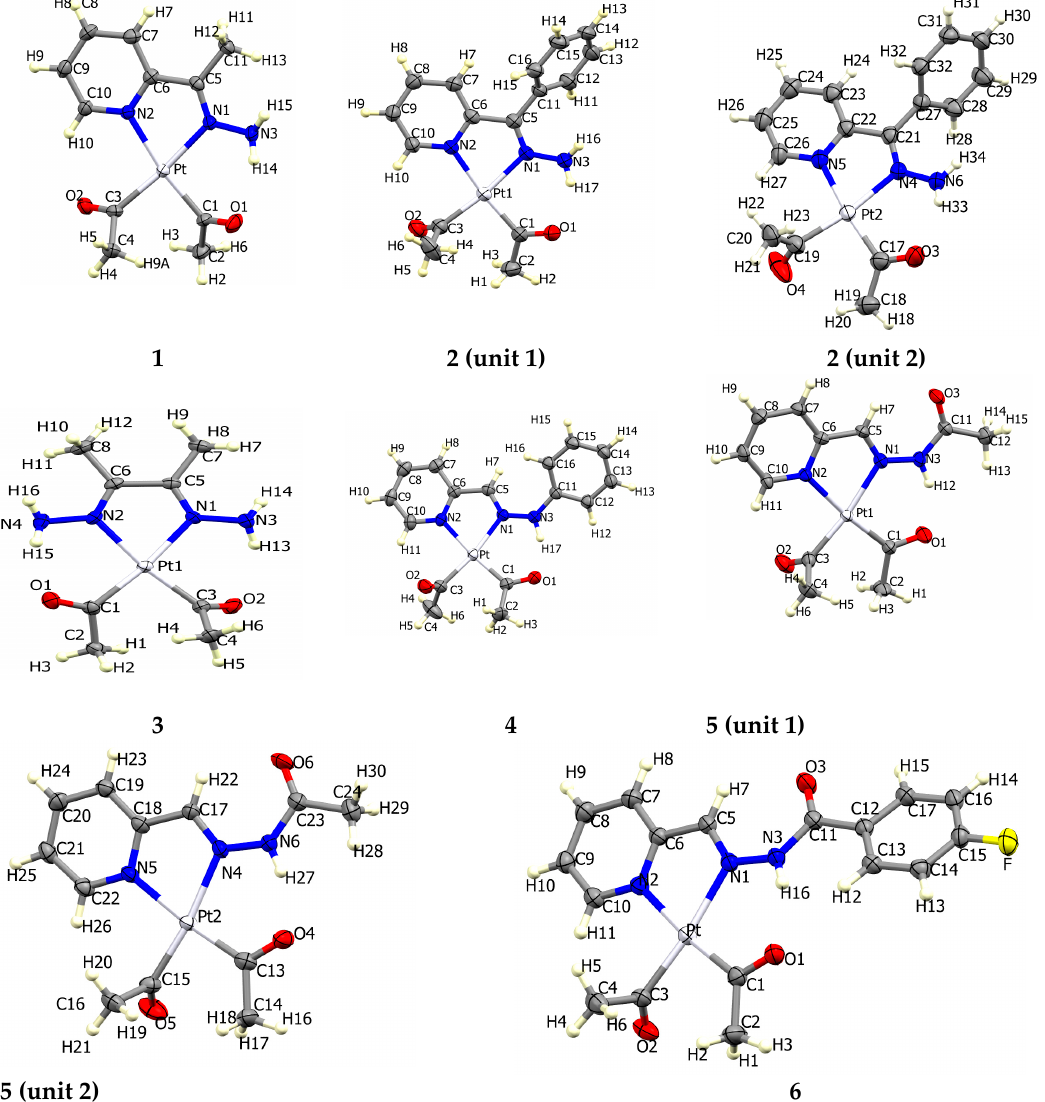
Figure 1. Atomic numbering in the six Pt complexes (front view).